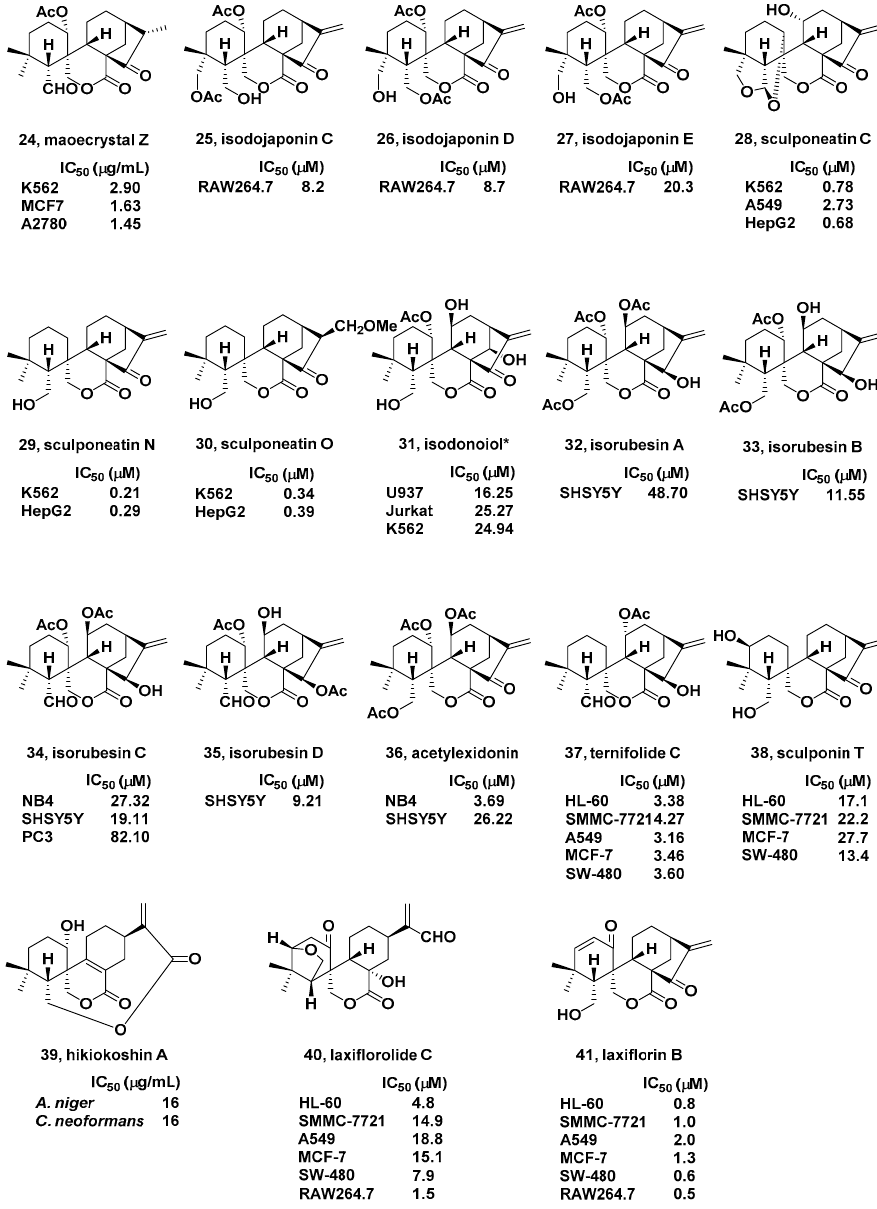
Figure 3. Chemical structures of natural spirolactone-type diterpenoids 24 – 41.